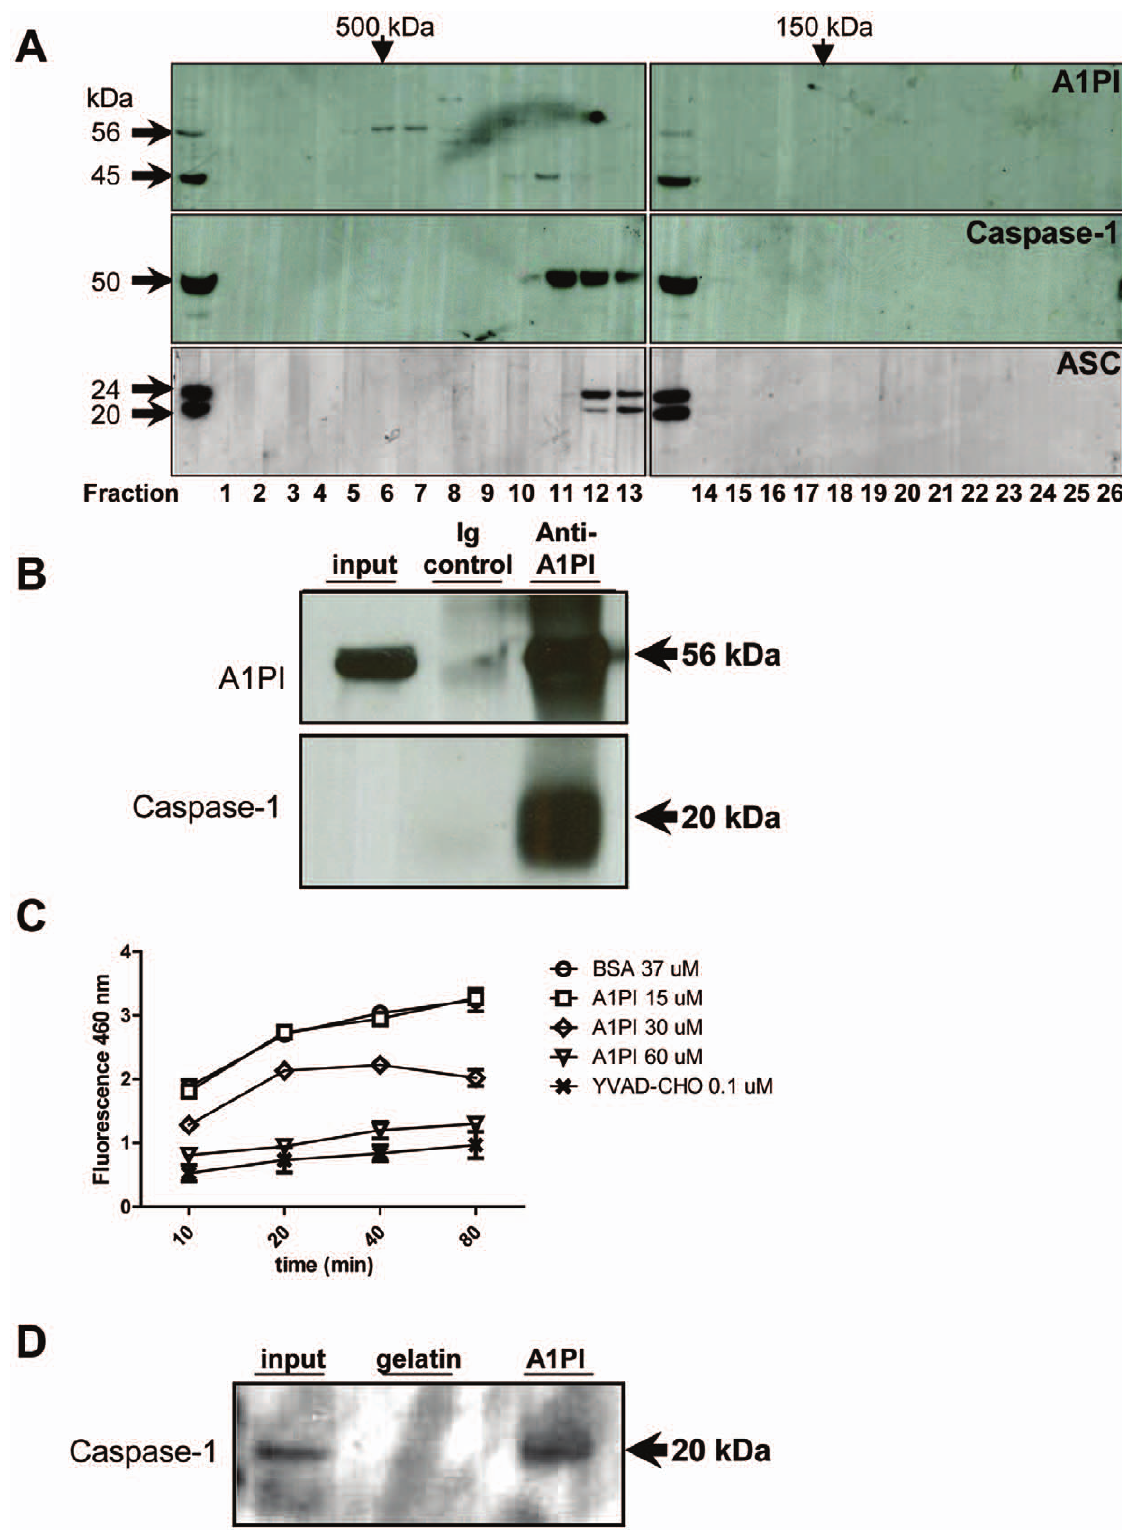
Figure 5. A1PI Interacts with Caspase-1 in Monocyte Cytosol. A) Cytosolic preparations of THP-1 cells activated 18 hours with PMA were applied to a Superdex S-200 column. Fractions 6 through 24 were analyzed by SDS-PAGE and immunoblot with antibodies directed to A1PI (top panel), caspase-1 (middle panel), and ASC (bottom panel). B) THP-1 cells activated overnight with PMA were pulsed for 1 hour with 20 m M nigericin before hypotonic lysis. Immunoprecipitation was performed using an irrelevant control IgG or A1PI-directed antibodies. Precipitated proteins were analyzed by immunoblot with anti-A1PI (top panel) or anti-caspase-1 (lower panel). C) Graded amounts of plasma derived A1PI, BSA control, or small